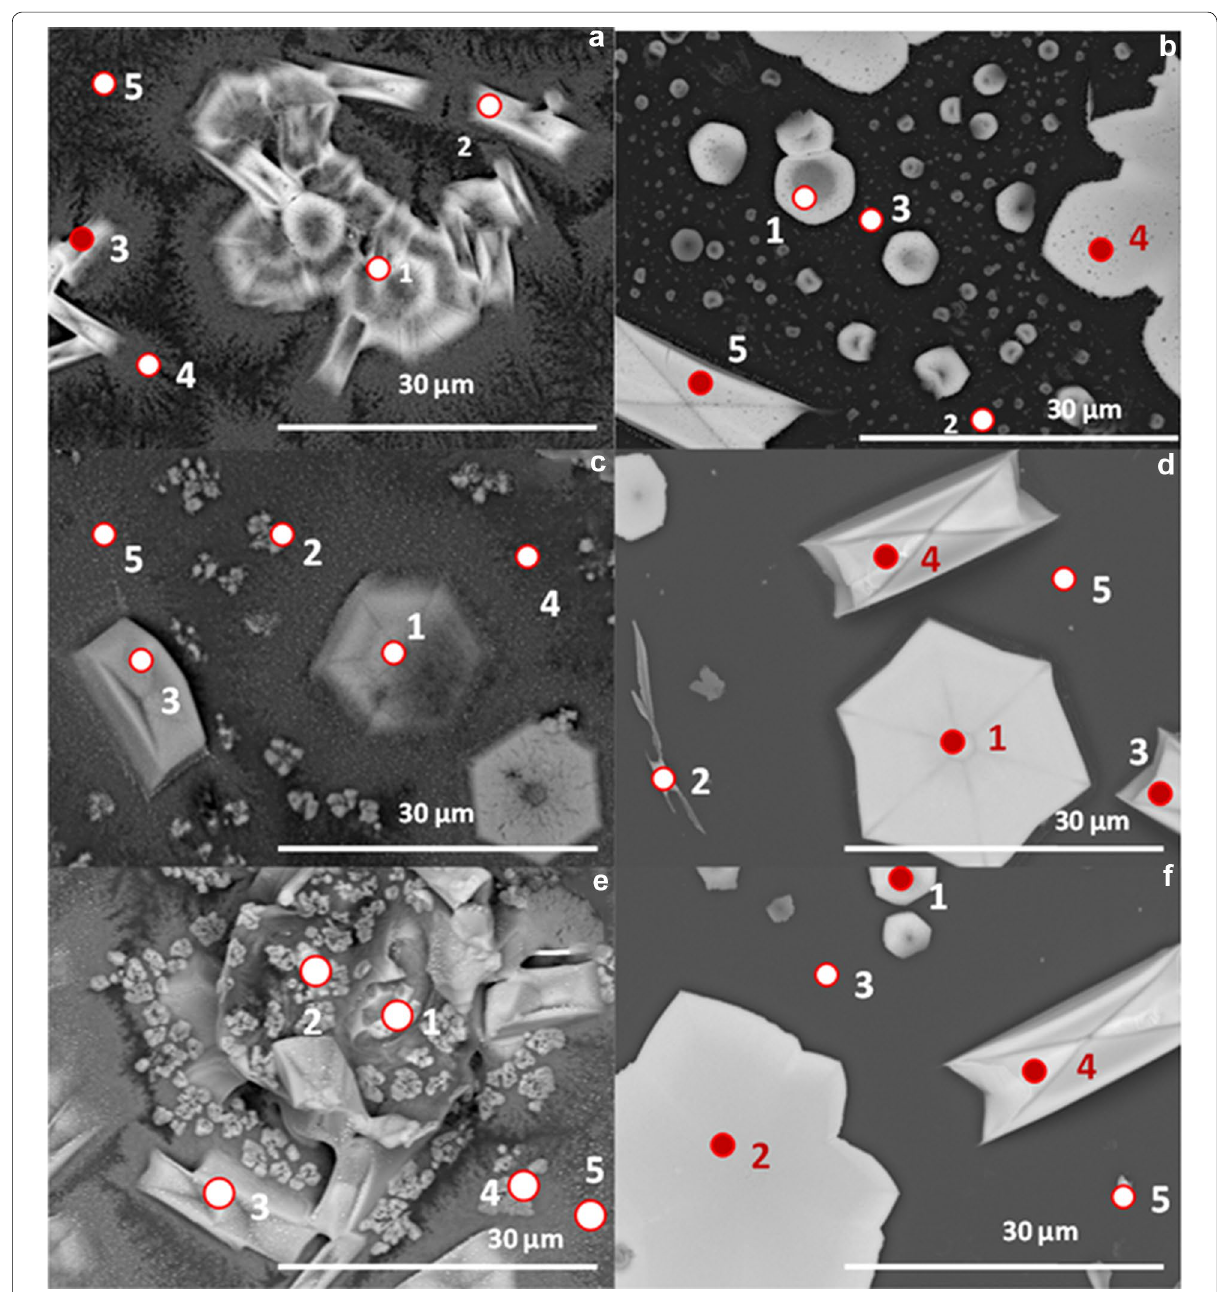
Fig. 4 SEM images observed for elemental analysis of A 3 B 2 X 9 films [(CH 3 NH 3 ) 3 Bi 2 I 9 : ( a , b ); (CH 3 NH 3 ) 3 Sb 2 I 9 : ( c , d ); (CH 3 NH 3 ) 3 SbBiI 9 : ( e , f )] grown on dif- ferent substrates